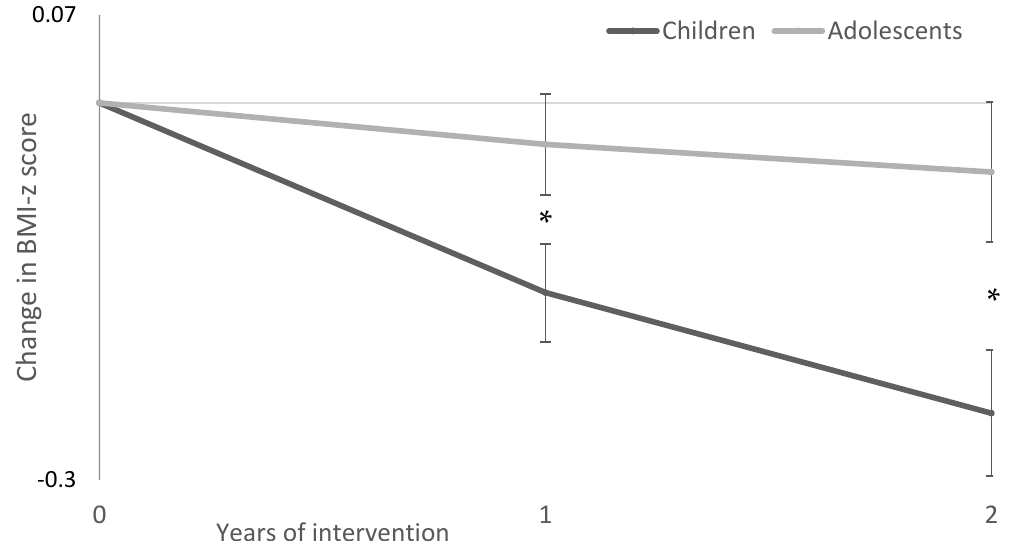
Figure 2. Decrease in BMI z-score after one and two years of intervention in children and adolescents determined by a marginal model for repeated measures (including group, time, and their interac- tion). Data presented as estimated marginal means and standard error. * p value ≤ 0.05, statistically different between children and adolescents.